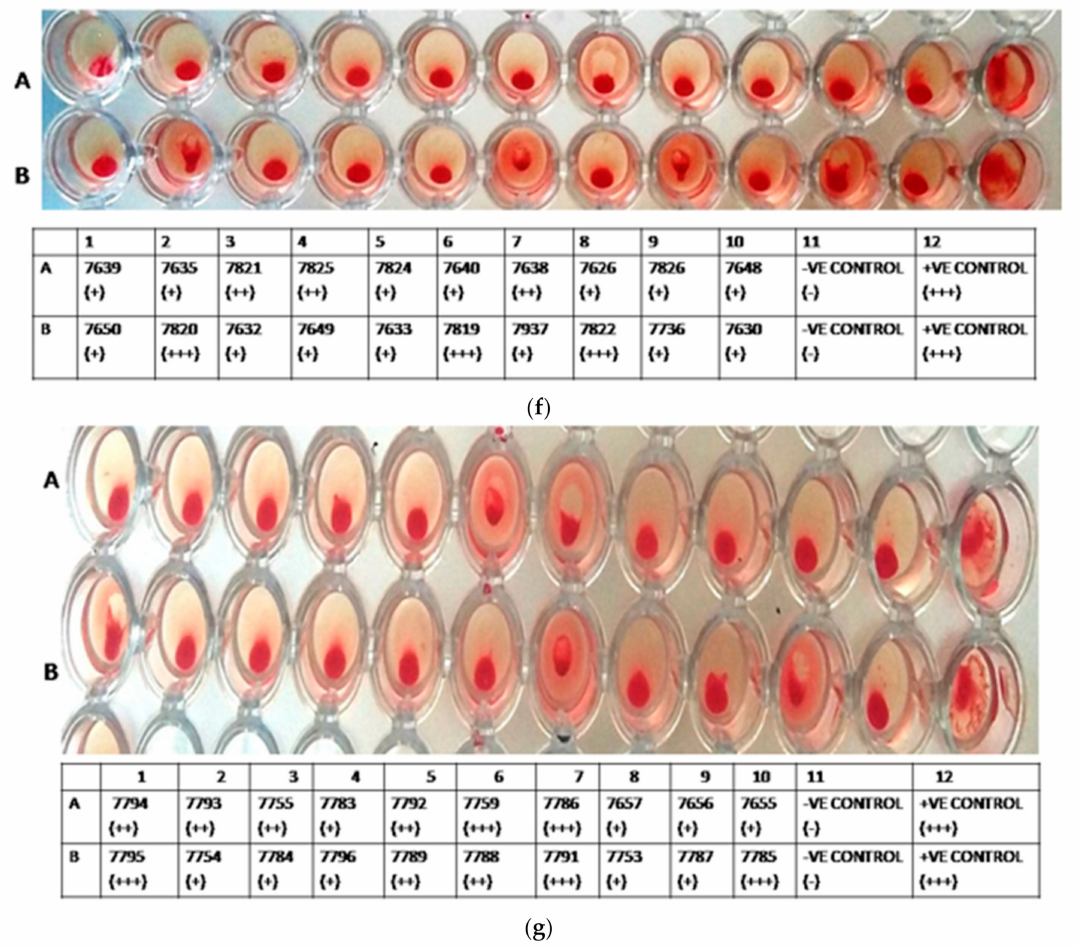
Figure 1. HA capability of rice ( Oryza sativa L.) lectins ( a – g ) against 5% Californian breed rabbit RBCs. The + signs are showing HA activity. The HA activities for different rice genotypes are weak (+), high (++/+2), highest (+++/+3) and negative (-), using 5% Californian breed rabbit